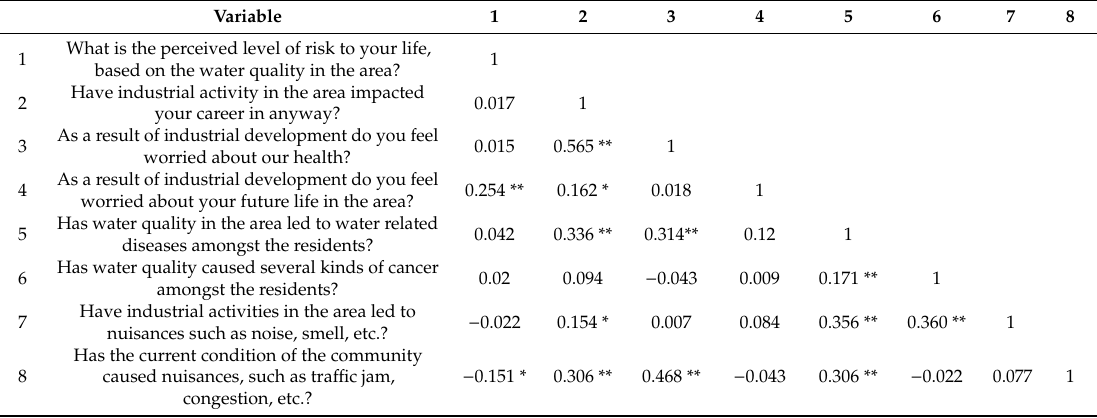
Table 5. Correlation coe ffi cients of risk perception